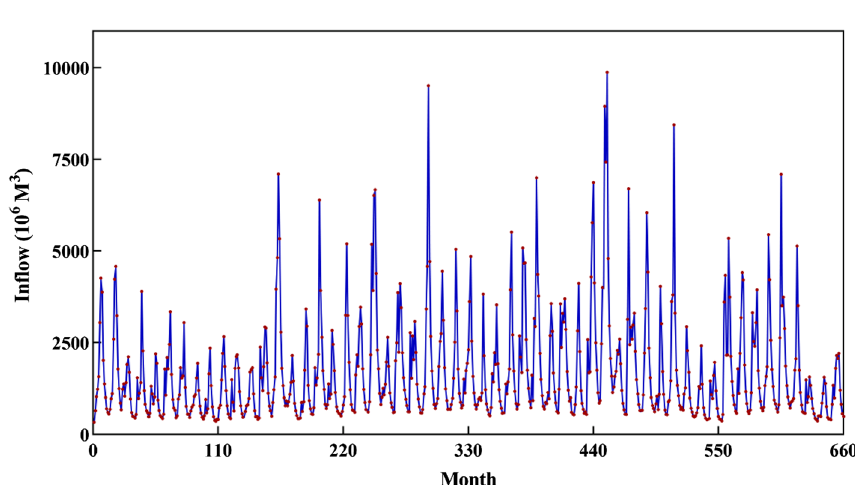
Figure 4. Monthly inflow into the multi-reservoir